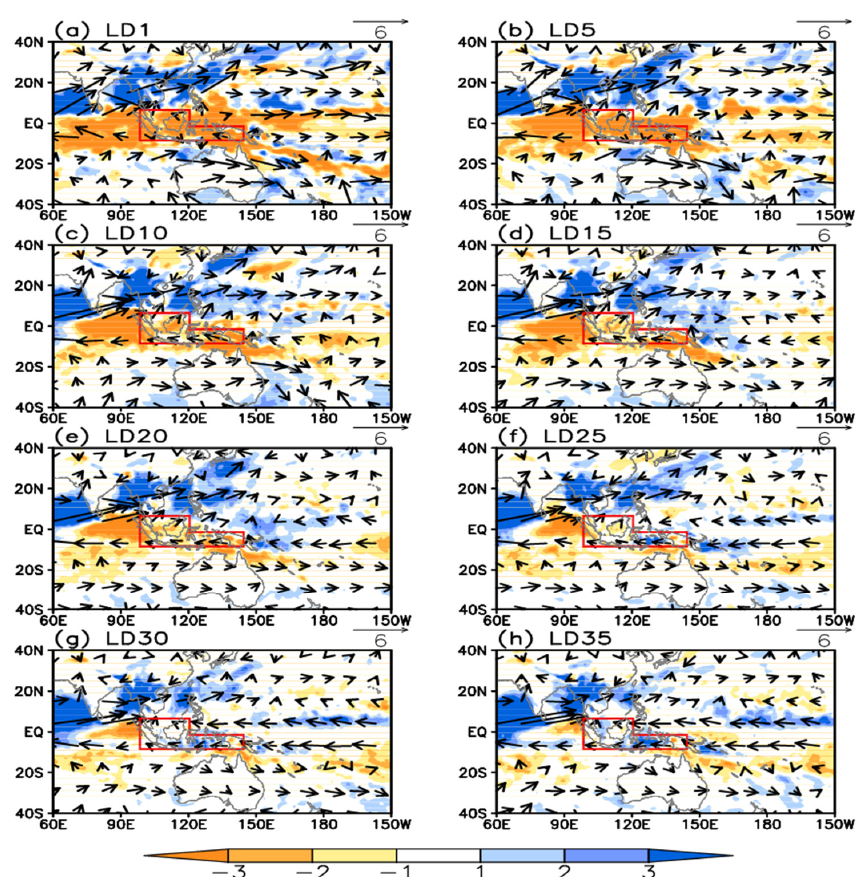
Figure 11. Differences in rainfall (shaded areas; mm/day) and 850-hPa winds (vectors; m/s) between 28th–29th pentad mean and 25th–26th pentad mean for CFSv2 predictions in ( a ) LD1; ( b ) LD5; ( c ) LD10; ( d ) LD15; ( e ) LD20; ( f ) LD25; ( g ) LD30; and ( h ) LD35.